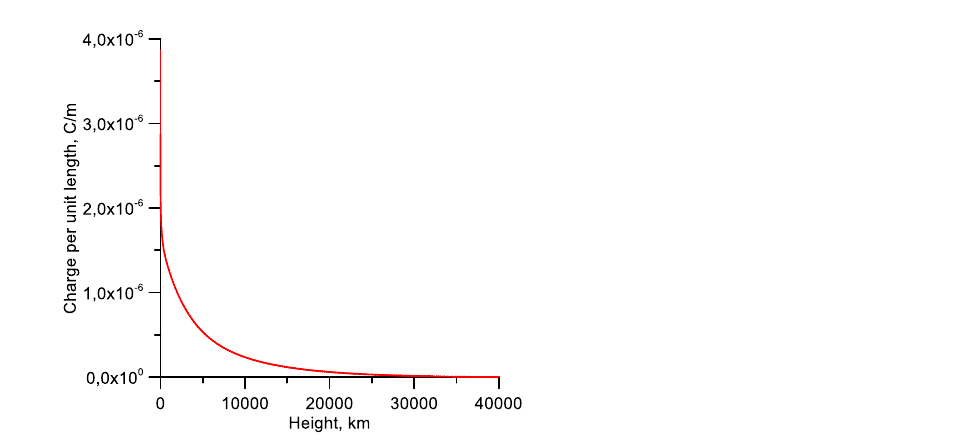
Figure 2. The charge per unit length induced on the macro channel when its tip is at ground level (2 m above the ground) by the fair-weather atmospheric electric field.